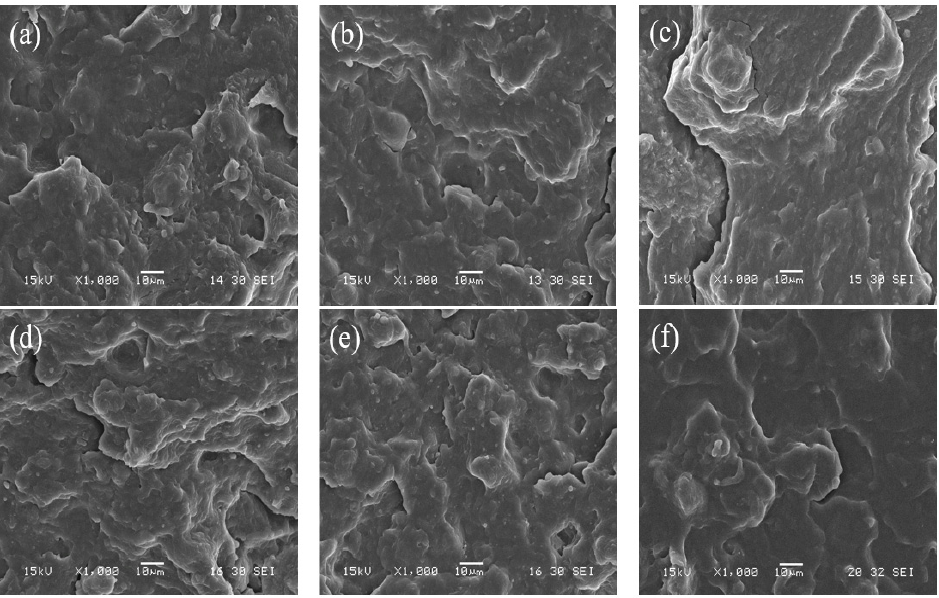
Figure 3. SEM micrographs of the cryogenic fracture surface from the di ff erent spaghe tt i-type pasta systems studied: ( a ) NSt, ( b ) NSt + Bu, ( c ) NSt + Bu + TAc, ( d ) OSt, ( e ) OSt + Bu and ( f ) OSt + Bu + TAc. Table 2. RDS, SDS, TDS and RS contents from the di ff erent cooked spaghe tt i-type pasta systems studied.